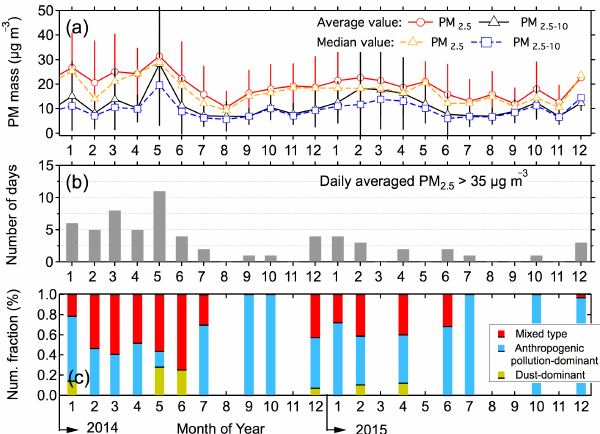
Figure 6. (a) The monthly mean and median values of mass concen- trations of PM 2 . 5 and PM 2 . 5 − 10 , (b) number of days with daily av- eraged mass concentrations of PM 2 . 5 exceeding 35µgm − 3 (the Na- tional Ambient Air Quality Standard (NAAQS) of PM 2 . 5 in Japan), and (c) contributions of different aerosol types to substandard air quality days at the site during the observation